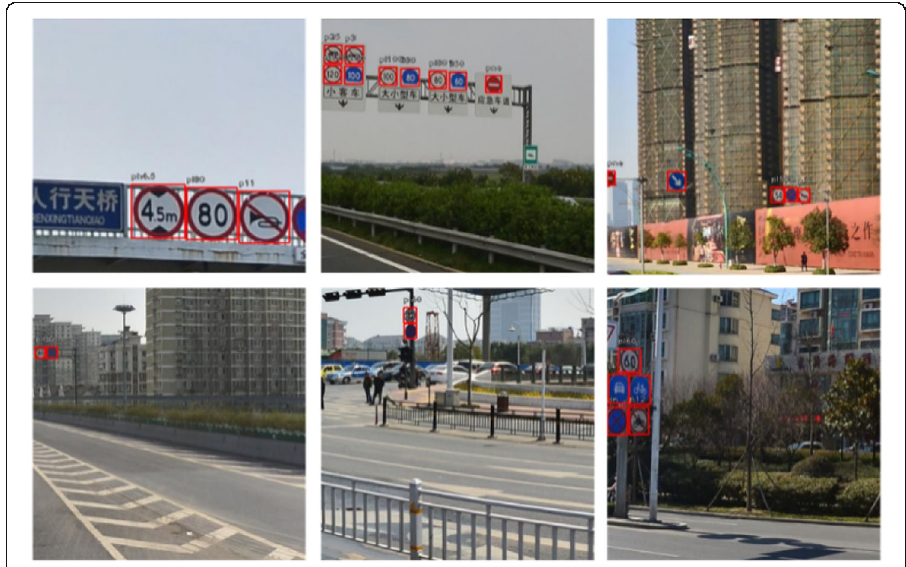
Fig. 1 Object detection results of some real traffic scenes. Our system works very well in a complex scene where objects are small and highly